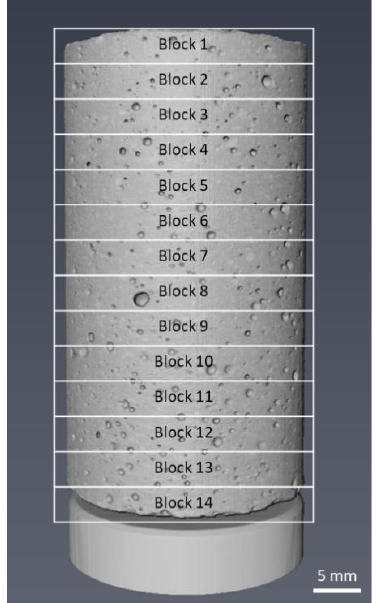
Figure 5. Reconstructed volume image mixture 1 concrete sample, captured using µCT imaging.